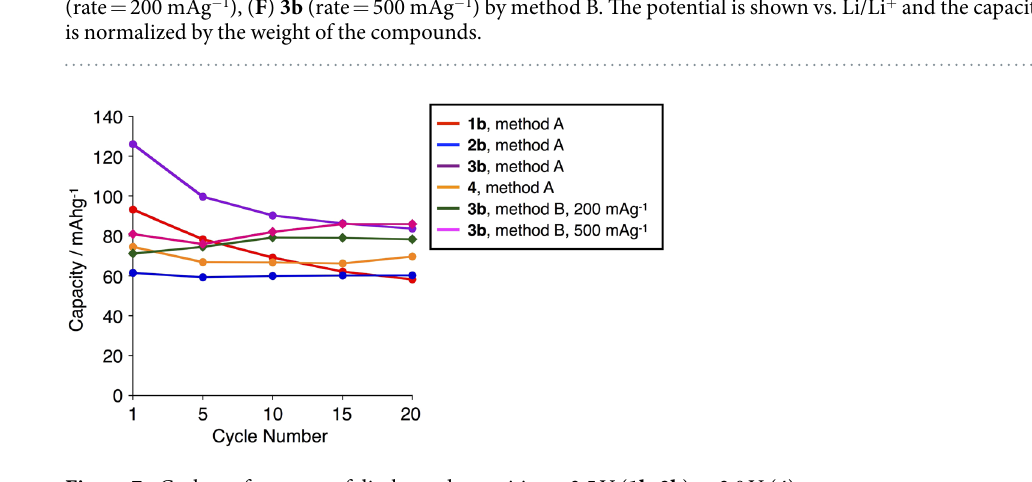
recycling charge/discharge process, the lack of a plateau for 4 was not due to the decomposition of the compound. This suggests that its redox reaction gradually occurs when the voltage decreases, which is probably caused by the difference in molecular skeleton. The calculated capacities per weight of compounds 1b - 3b were 65, 81, and 68 mAhg − 1 for one-electron redox, respectively. For 3b , larger capacity was observed in the first discharge process, which is probably due to non-Faradic reaction and SEI in the first discharge process. The observed capacities of 1b and 3b were gradually decreased by the cycling charge/discharge process (Fig. 7), but the extent of decrease of capacity per cycle became smaller. In contrast to 1b and 3b , the observed capacity of 2b did not change by the recycling process, which is attributed to the lower solubility of 2b in the electrolyte solution. The capacity of the plateau region of 3b was comparable to the calculated one for the one-electron redox, while those of 1b and 2b were slightly smaller than the calculated ones. Since phenothiazine dimer 3b was easily prepared in the fewest steps among 1b - 3b , we prepared another cathode electrode composite by a different method B using 3b . Cathode electrode composites (0.1 mm thickness) were prepared by mixing the compound (30 wt%), polyvinylidene dif- luoride (PVDF) (10 wt%), and conductive carbon black (TOKA BLACK 5500 of TOKAI CARBON) (60 wt%) with N -methyl-2-pyrrolidone on an aluminum sheet. Compared with method A, the amount of 3b was increased up to 30 wt% and the thickness of the cathode electrode composite was decreased to 0.1 mm. Lithium batteries were assembled with the cathode electrode composite, and the performance was investigated. The charge/dis- charge performance of the batteries was measured at a constant current (200 mAg − 1 or 500 mAg − 1 ) for 20 cycles between 2.5–4.2 V. Selected charge/discharge curves and the cycle performance of discharged capacities at 2.5 V are shown in Figs 6(E,F) and 7. Compared with the results obtained by using method A [Fig. 6(C)], the plateau